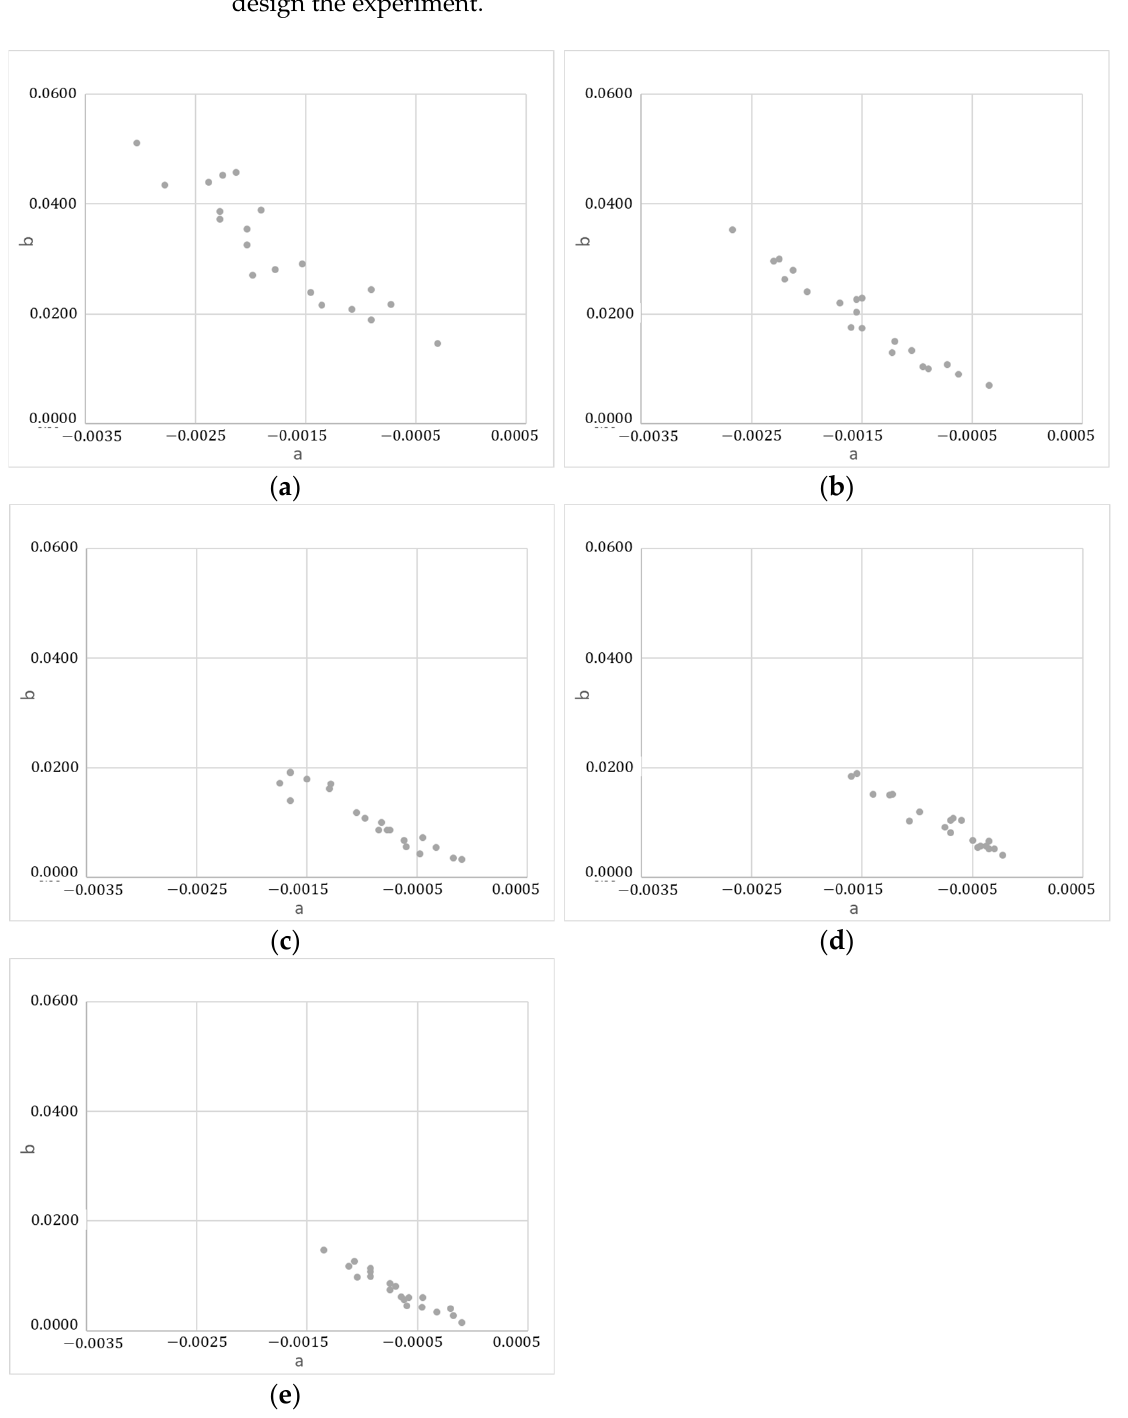
Figure 7. The 5 scatter charts of coefficients a and b corresponding with 5 levels of flow velocity: ( a ) v = 0.71–0.80 m/s; ( b ) v = 0.63–0.71 m/s; ( c ) v = 0.50–0.63 m/s; ( d ) v = 0.44–0.50 m/s; ( e ) v < 0.44